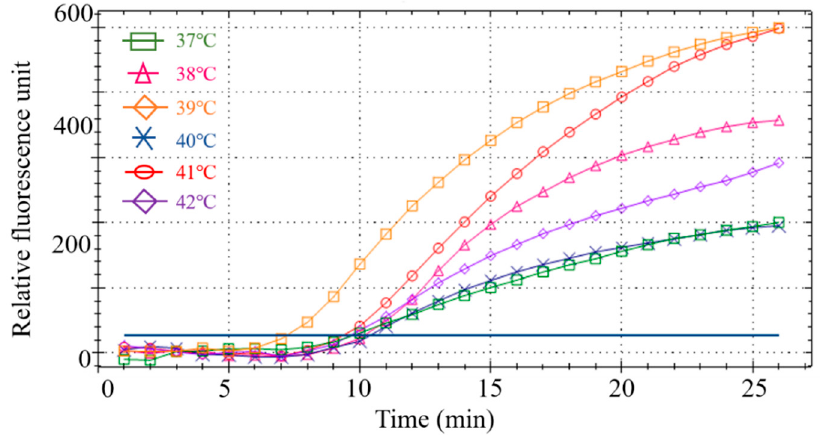
Figure 4. Screening of the optimal temperature for the RPA reaction.